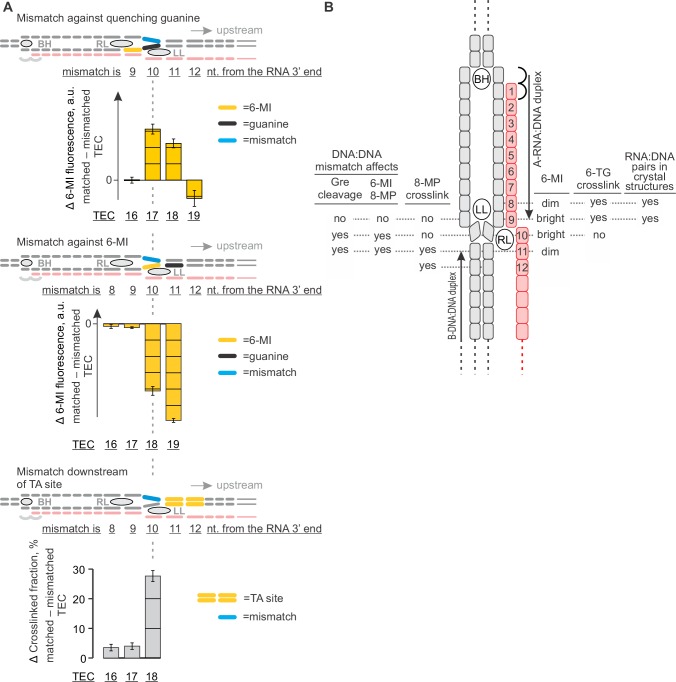
The effects of DNA mismatches suggest the minimal transcription bubble.(A) DNA:DNA mismatches against quenching guanine (top) and 6-MI (middle), or downstream of the TA site (bottom) alter the TEC properties when positioned ten nucleotides upstream of the RNA 3' end and further upstream. Error bars indicate the range of duplicate measurements or SDs of several measurements (Table 5). (B) Mapping the upstream edge of the transcription bubble based on data in Figures 3C, 4A, 5A, 6A and 7A.